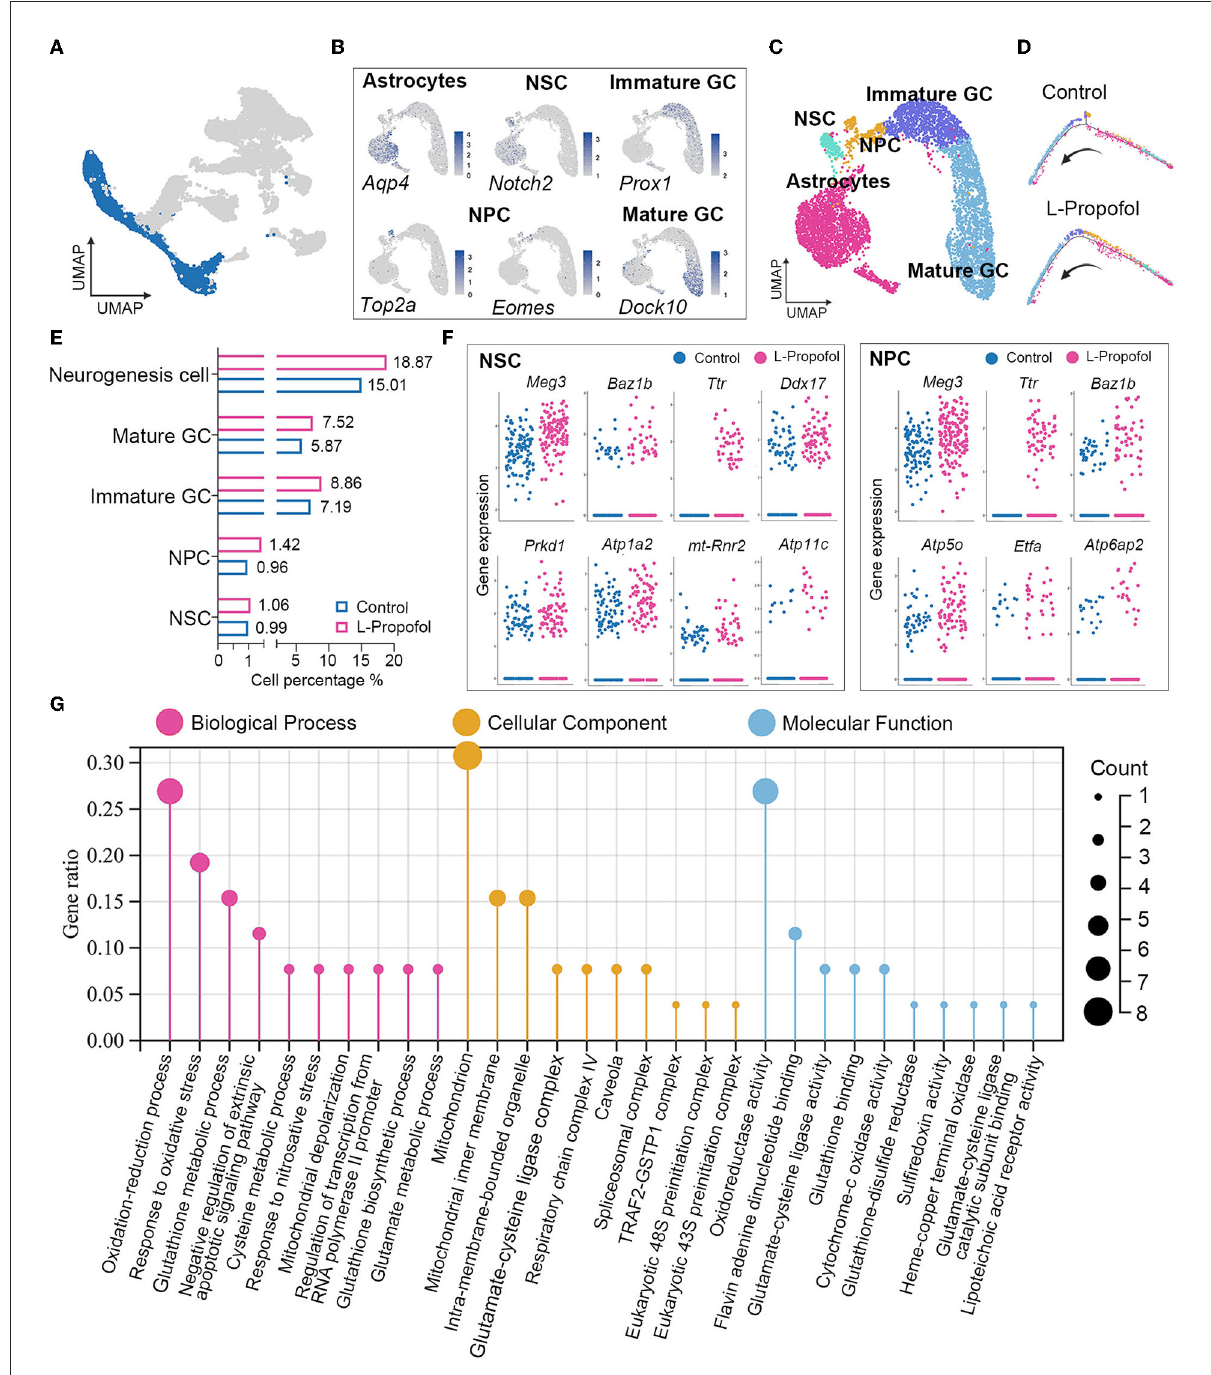
FIGURE4 Enhancement of mitochondria metabolism in NSCs post-treatment revealed by transcriptome analysis. (A) Target clusters of neurogenesis-related cell types for cell regrouping. (B) Expression of representative markers for each cell type. Cells were colored according to their expression levels, ranging from “not detected” (gray) to “highest detected” (blue). (C) Distribution for neurogenesis-related cell types in UMAP analysis in which clusters were separated by colors. (D) Pseudotime analysis of neurogenesis in Control group and L-Propofol group, respectively. (E) Quantification of the percentage of NSCs, NPCs, immature GCs, mature GCs, and overall neurogenesis cells among all cells showing overall activated neurogenesis in the L-Propofol group. (F) Level of gene expression showing the enhancement of neurogenesis and mitochondrial metabolism-related genes in NSCs (Meg3: p < 0.001, Ttr: p < 0.001, Baz1b: p = 0.01, Ddx17: p = 0.03, Atp1a2: p < 0.001, Prkd: p = 0.04, mt-Rnr2: p < 0.001, Atp11c: p = 0.04) and NPCs (Meg3: p < 0.001, Ttr: p < 0.001, Baz1b: p < 0.001, Atp5o: p = 0.01, Etfa: p = 0.03, Atp6ap2: p < 0.001) between Control and L-Propofol. (G) GO analysis showing the mitochondrial metabolism pathway enrichment in NSCs in the L-Propofol group compared with the Control